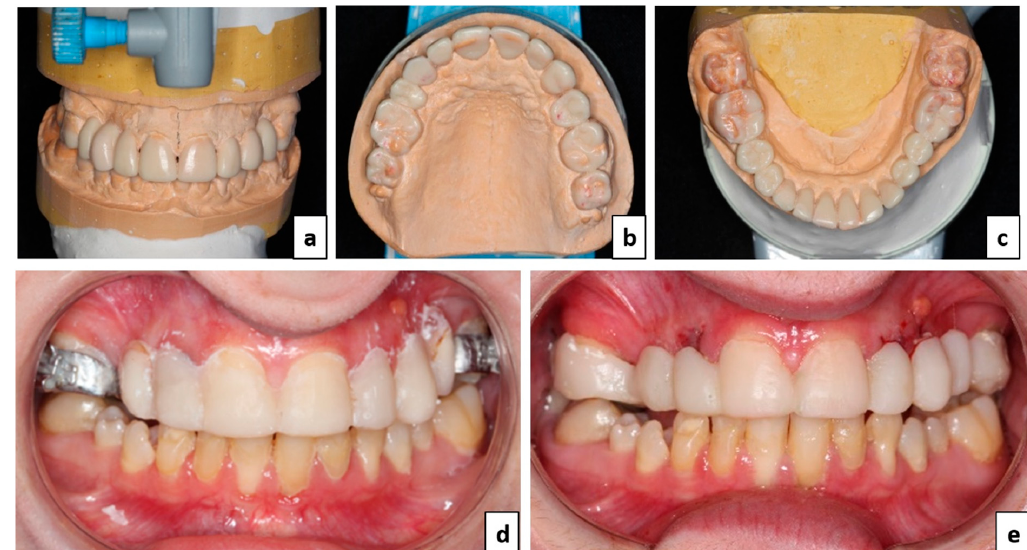
Figure 4. Temporary treatment of the maxilla with a fixed tooth supported prosthesis. ( a – c ) Prosthetic project defined by the wax-up and set-up (frontal and occlusal views); ( d ) mock-up from the wax-set-up; and ( e ) 1st generation temporary bridge made from the wax-up and set-up.